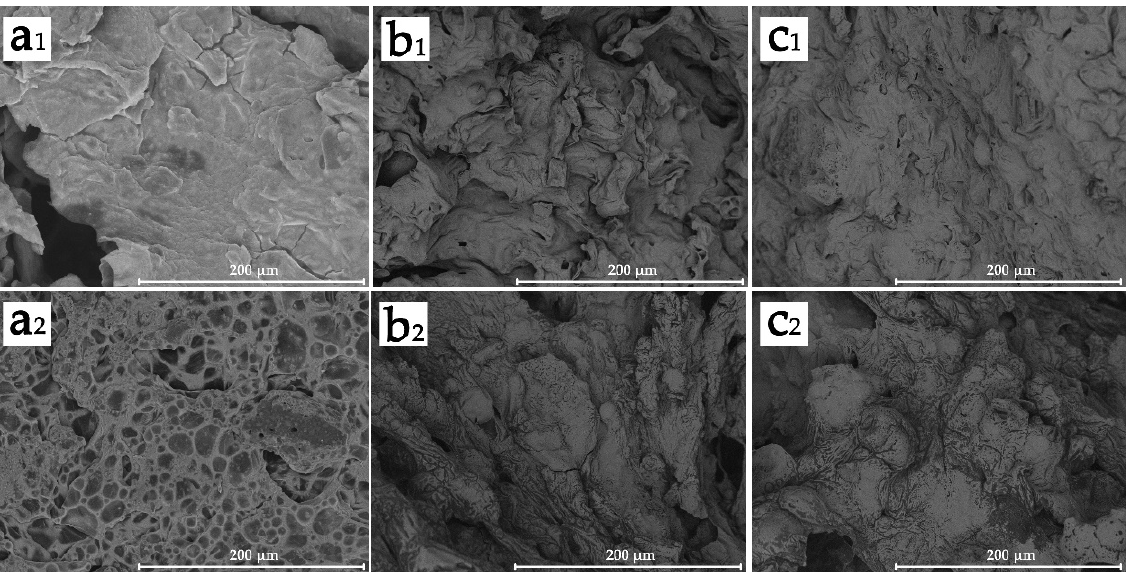
Figure 13. SEM images of residues on outer surface (( a 1 ): FPLA-B3; ( b 1 ): FPLA-C33; ( c 1 ): FPLA-C53) and internal